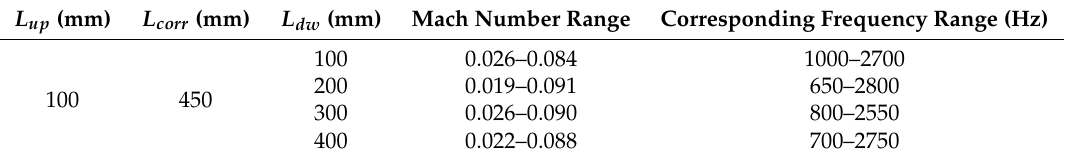
Table 7. Mach number and corresponding frequency range (Hz) for pipe systems in Case a-III.